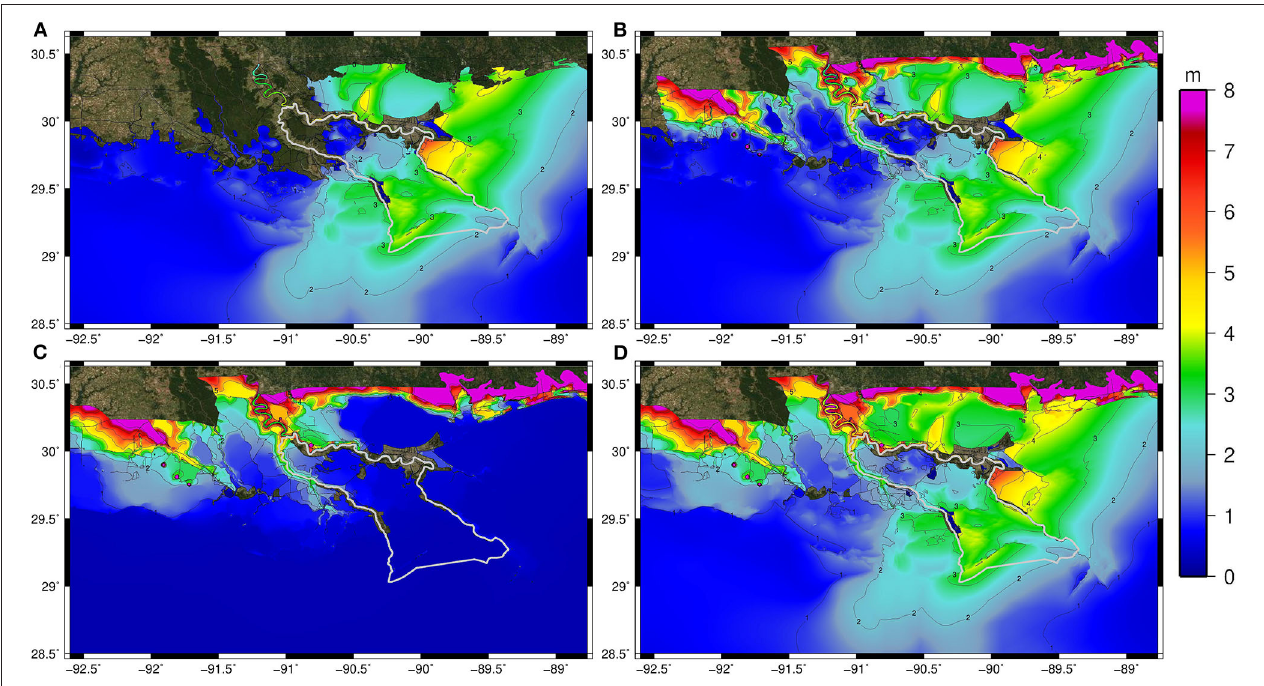
FIGURE 8 | Maximum of maximums (MOM) simulated peak water levels (m, NAVD88) for the Barataria watershed high event synthetic storms for (A) storm surge only (no rainfall), (B) storm surge and TC-driven rain, (C) antecedent rainfall only (no storm surge), and (D) antecedent rainfall, TC-driven rainfall, and storm surge in a single simulation.